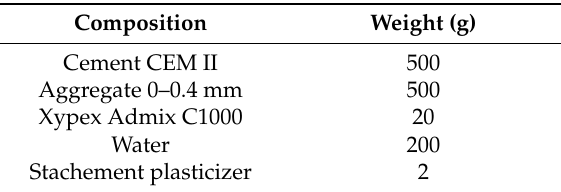
Table 3. Composition of specimens used in all phases.